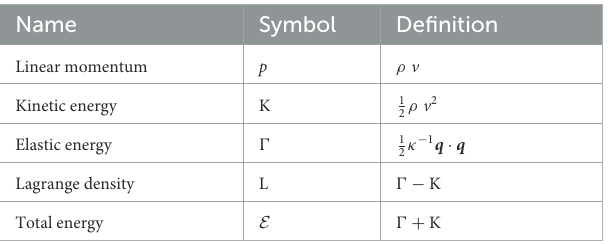
TABLE 1 Glossary of scalar wave equation quantities.